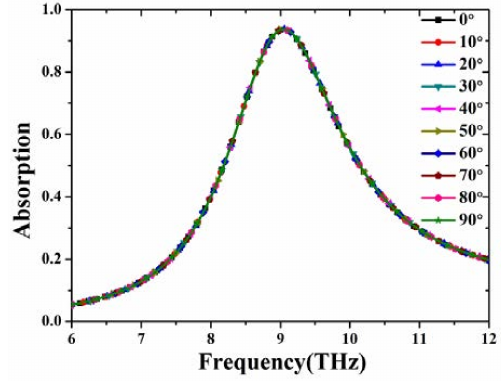
Figure 5. Simulated absorptivity under different polarization angles from 0 ◦ to 90 ◦ in steps of 10 ◦